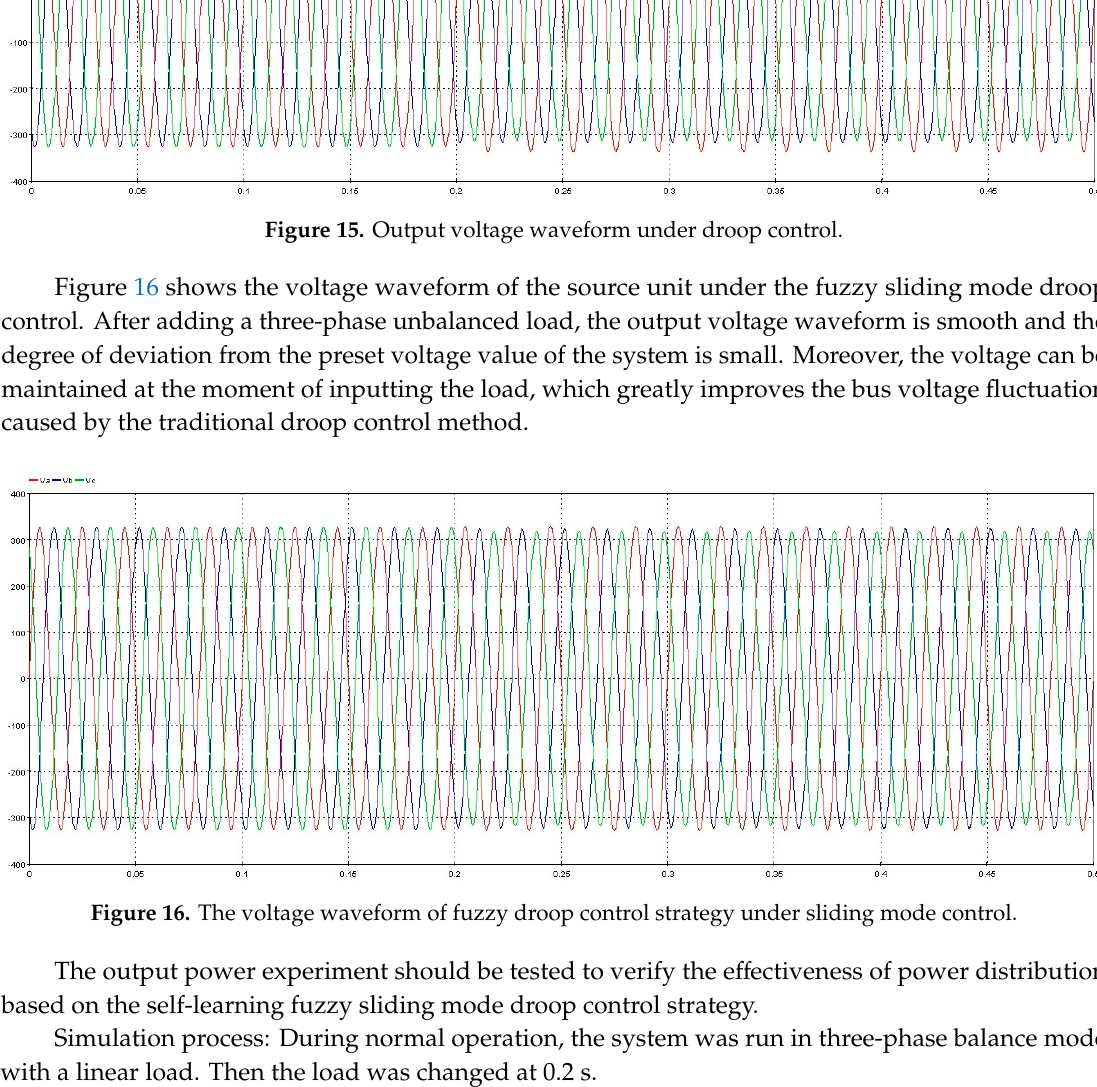
Figure 14. Current waveform under non-linear load.